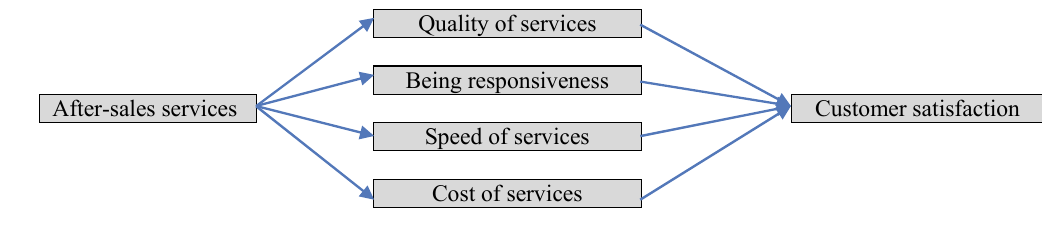
Fig. 2. The structure of the proposed